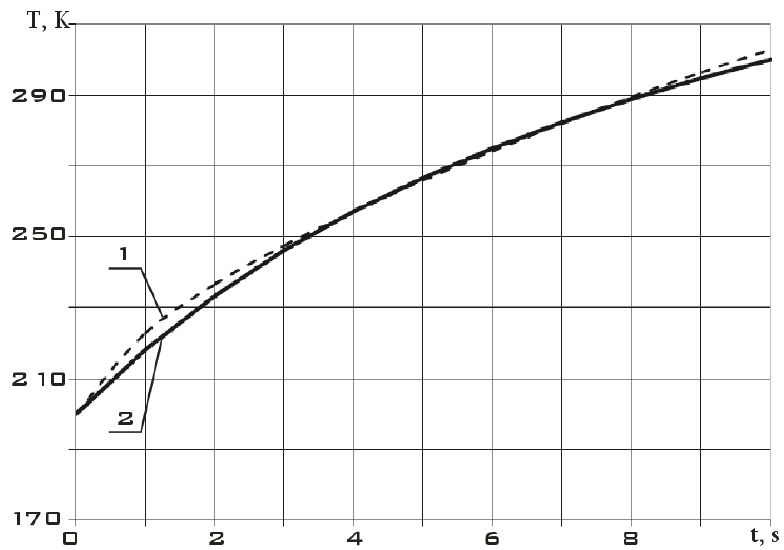
Figure 2. Comparison of temperature dynamics in the median plane ( z = h /2) of the plate: 1—according to [11], 2—according to the formula (35) at C = C = 200 K/m, a = 1 s.